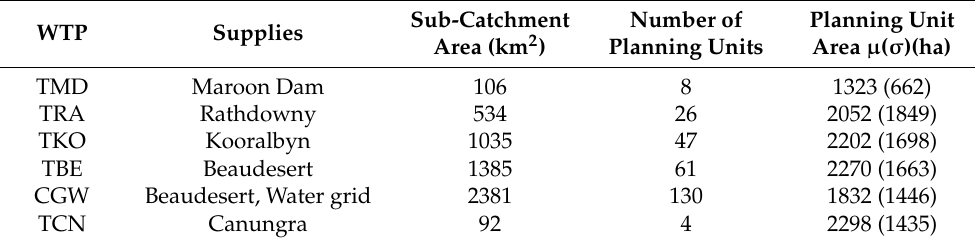
Table 1. Logan-Albert catchment water treatment plants